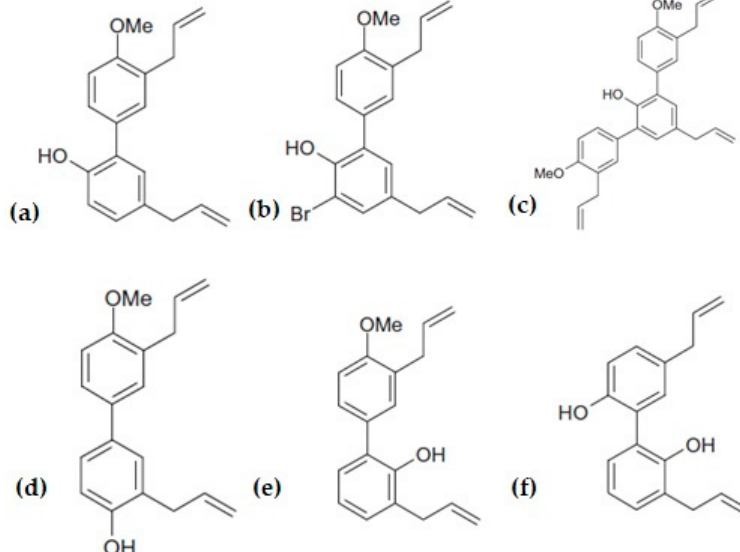
Figure 2. The structure of honokiol analogues. ( a ): 3,5’-Diallyl-2’-hydroxyl-4-methoxy-1,1’-biphenyl; ( b ): 3’-Bromo-3,5’-di-allyl-2’-hydroxyl-4-methoxy-1,1’-biphenyl; ( c ): 2,6-Di-(4’-methoxy-3’-allylphenyl)-1- phenol; ( d ): 3,3’-Diallyl-4-methoxy-4’-hydroxy-1,1’-biphenyl; ( e ): 3,3’Diallyl-2’-hydroxyl-4-methoxy- 1,1’-biphenyl; ( f ): 3’,5-Diallyl-2,2’-di-hydroxy-1,1’-biphenyl [24].